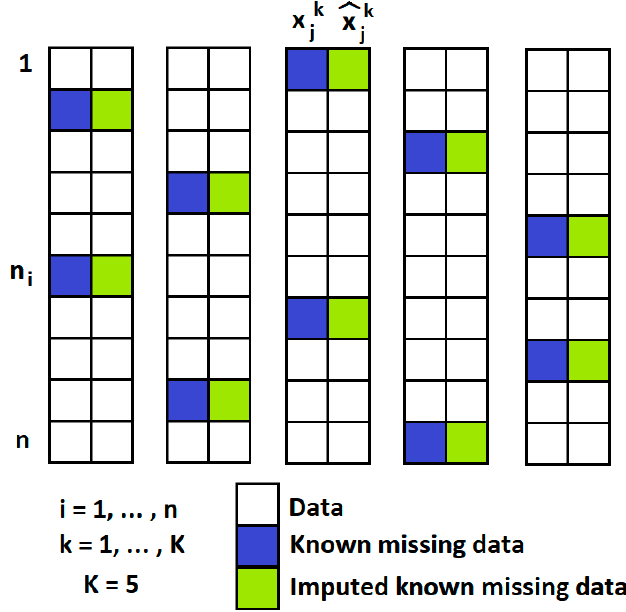
Figure 5. Comparison and measurement of performance.